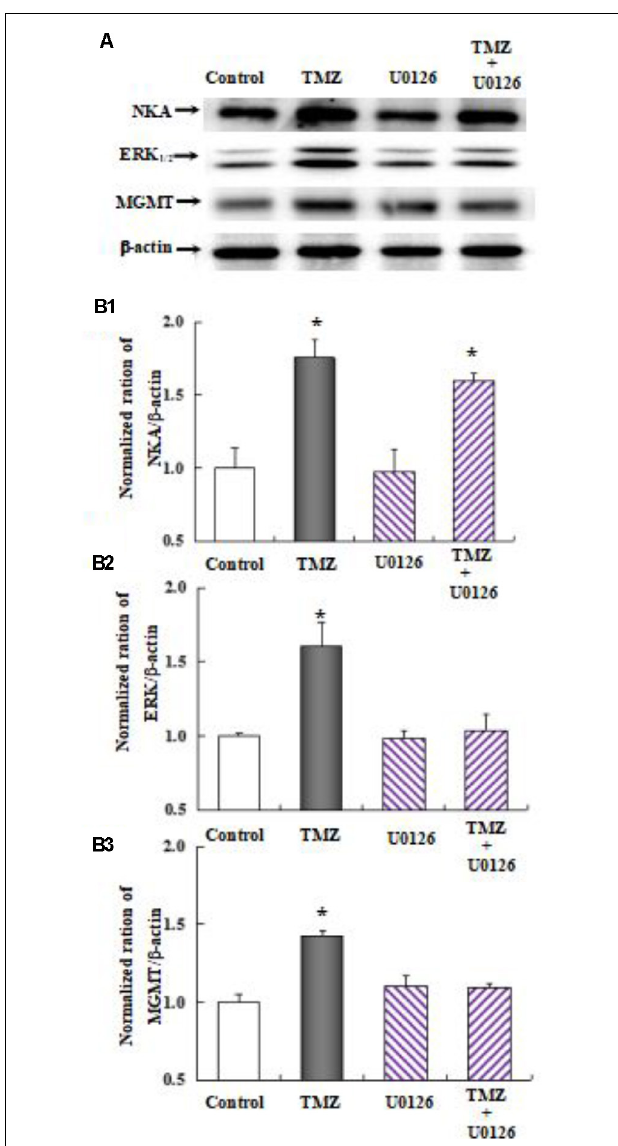
FIGURE 12 | Upregulation of TMZ-induced MGMT expression by activation of ERK 1 / 2 in U251 cells. (A) Cells were incubated for 48 h in the absence of any drug (Control) or in the presence of 5 µ M TMZ. In some experiments 10 µ M U0126, an inhibitor of MEK 1 / 2 , was added 4 h before the addition of TMZ. (B1) Mean Akt expression was quantified as ratios between Akt and β -actin. (B2) Mean ERK 1 / 2 expression was quantified as ratios between ERK 1 / 2 and β -actin. (B3) Mean MGMT expression was quantified as ratios between MGMT and β -actin. Similar results were obtained from three independent experiments. SEM values are indicated by vertical bars. ∗ Indicates a statistically significant ( P < 0.05) difference from the negative control